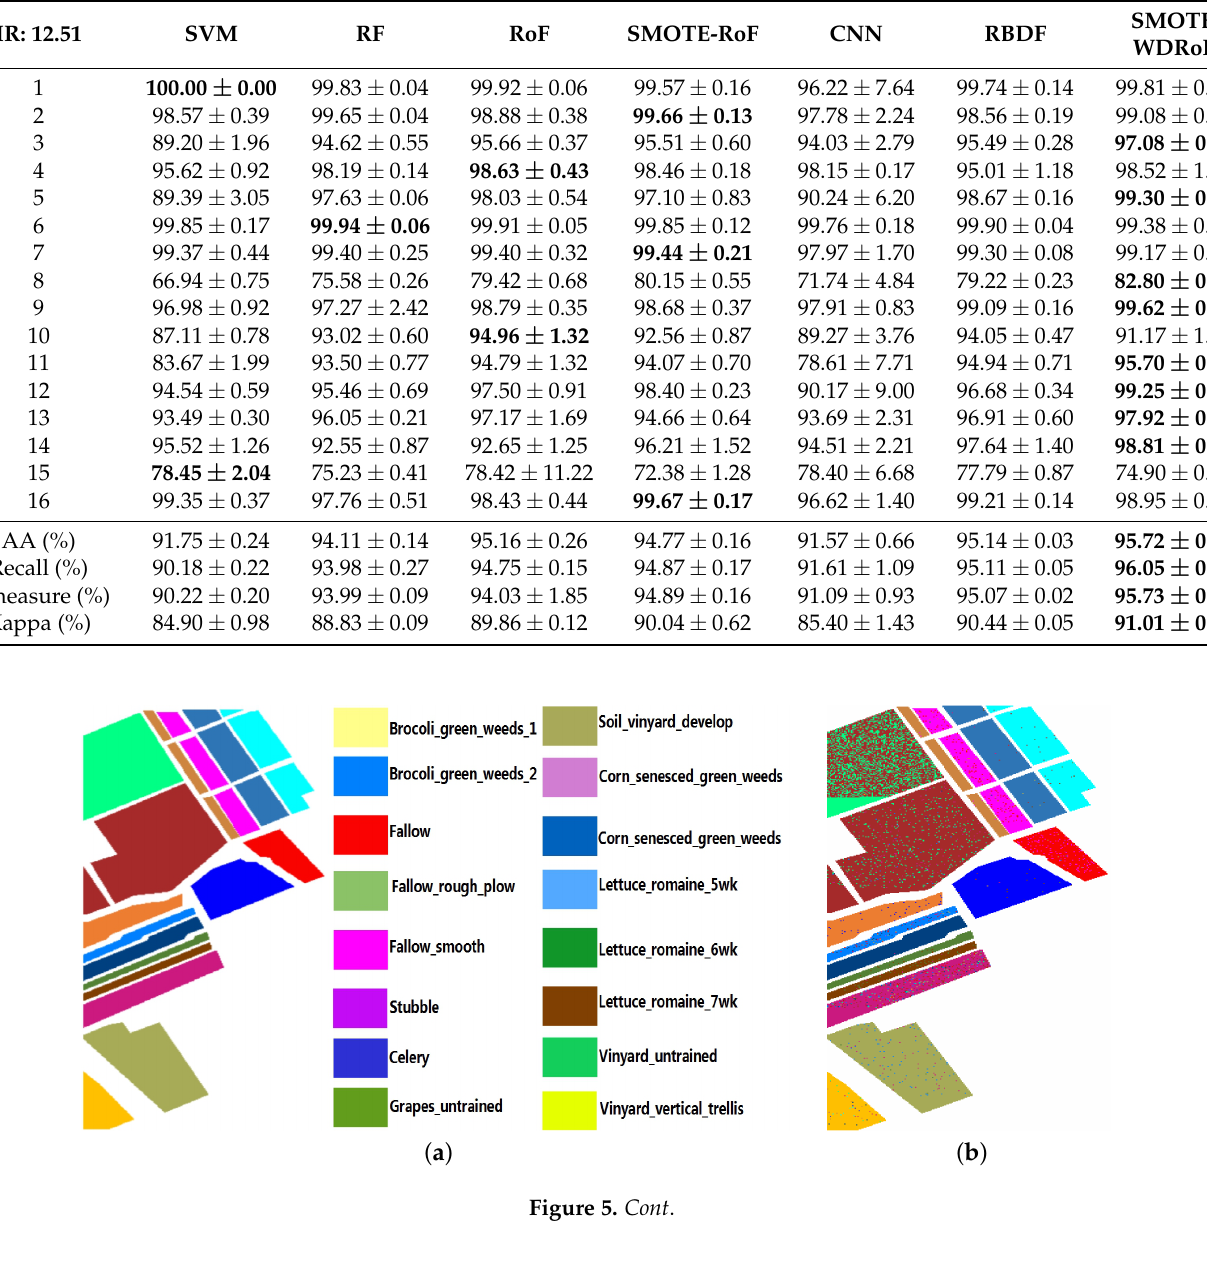
Table 4. Classification results (%) of the Salinas image, respectively obtained by SVM, RF, RoF, SMOTE-RoF, CNN, RBDF and the proposed SMOTE-WDRoF in the case of the imbalance ratio of 12.51.